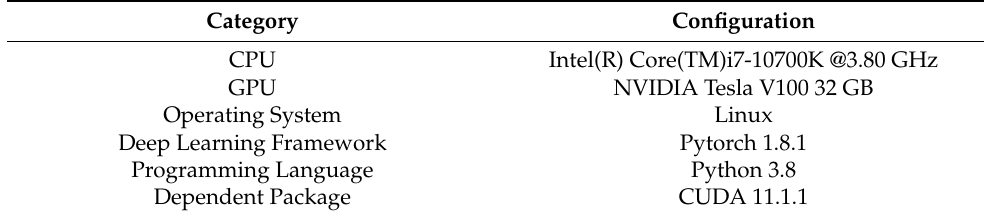
Table 1. Experimental platform environment